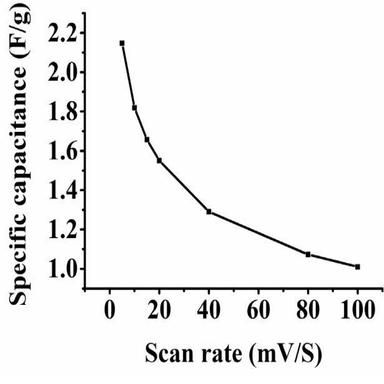
Scan rate (mV/s) of different CV vs calculated specific Capacitance (F/g).